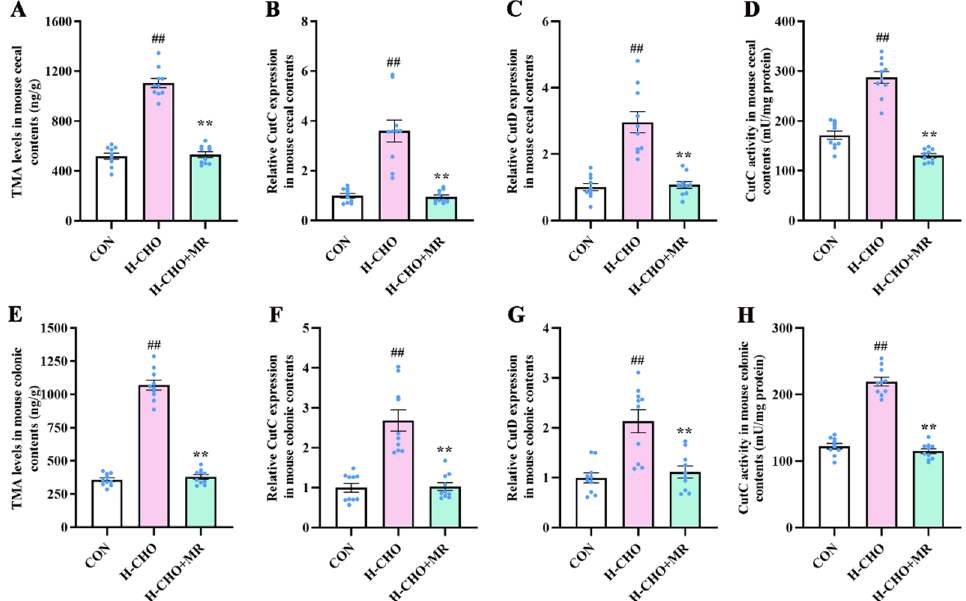
Figure 5. Effects of MR on TMA levels ( A , E ), CutC ( B , F ) and CutD ( C , G ) expression, and CutC ac- tivity ( D , H ) in mouse cecal contents and colonic contents under H-CHO diet conditions. MR,